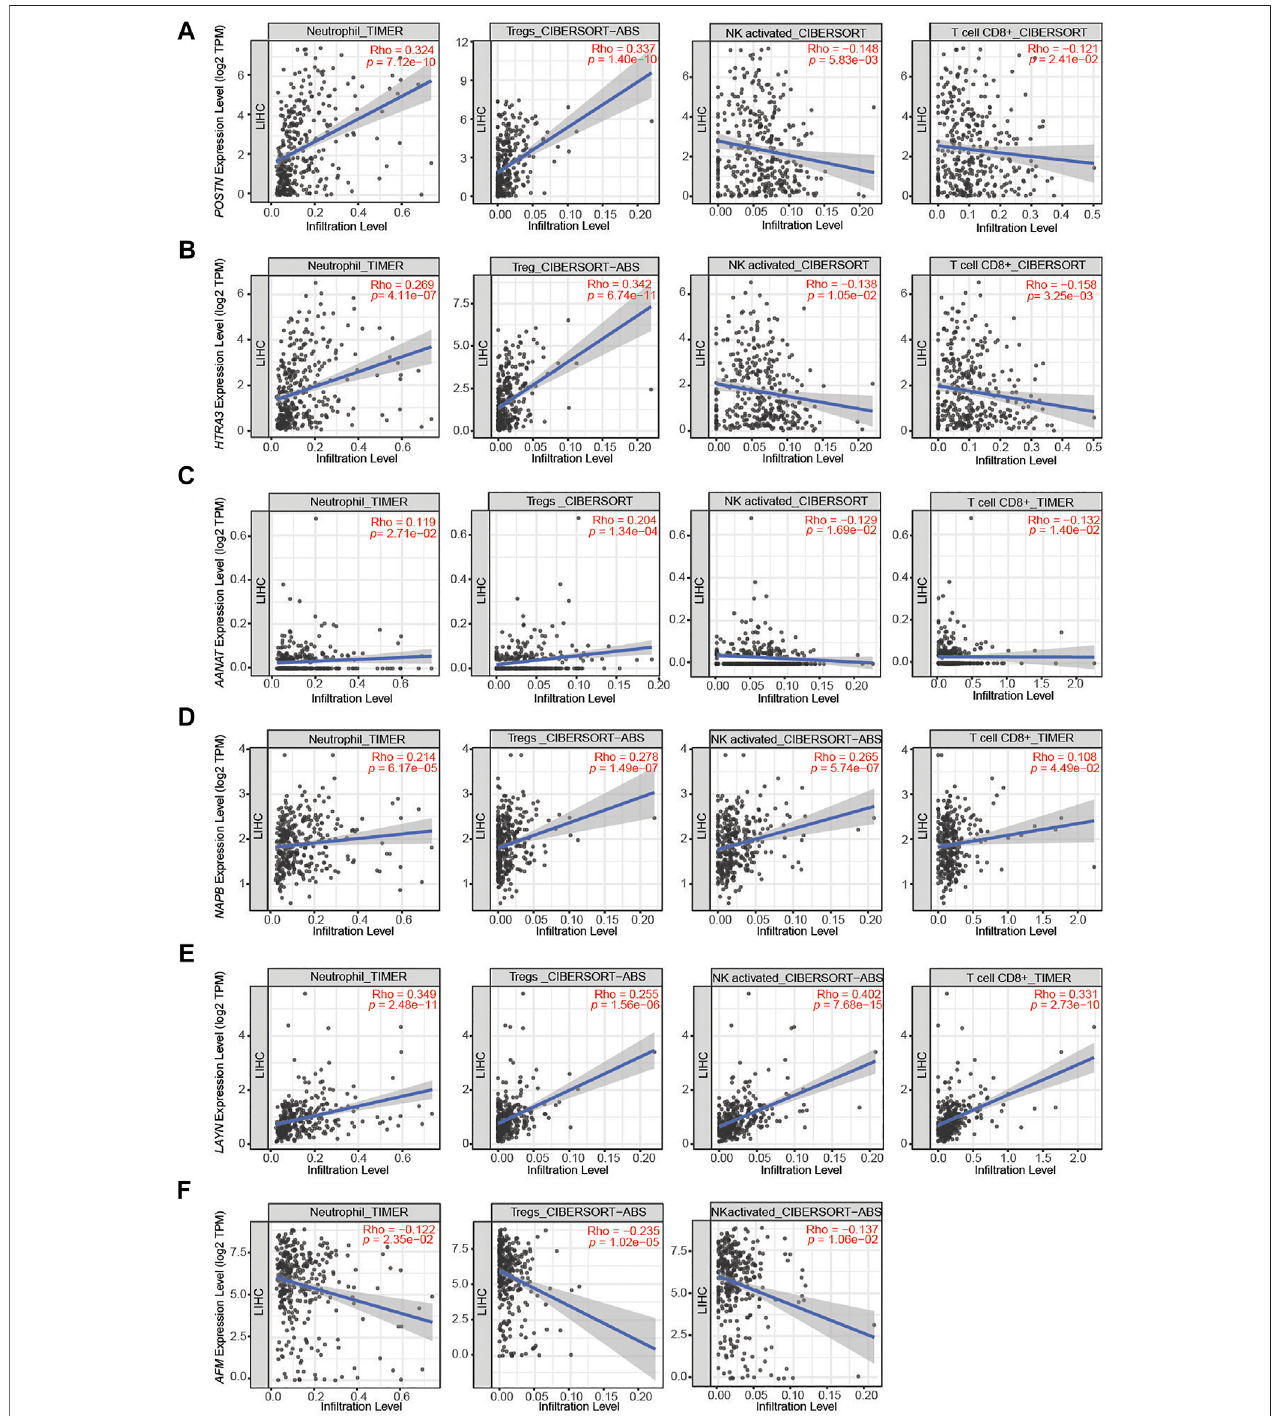
FIGURE4| CorrelationsbetweentheDEGsandimmunecellin fi ltrationinliverhepatocellularcarcinoma(LIHC). (A – C) Theexpressionlevelsof POSTN , HTRA3 and AANAT signi fi cantly positively correlated with the levels of neutrophil and Treg in fi ltration and negatively correlated with the levels of activated NK cell and CD8 + T cell in fi ltration. (D,E) The expression levels of NAPB and LAYN signi fi cantly positively correlated with neutrophil, Treg, activated NK cell and CD8 + T cell in fi ltration. (F) The expression levels of AFM negatively correlated with the levels of neutrophil, Treg and activated NK cell in fi ltration.